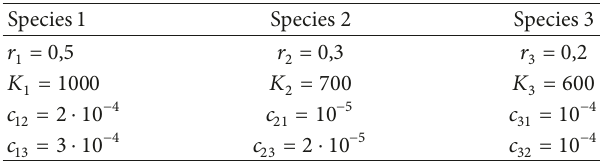
Table 1: Characteristics of the three marine species.